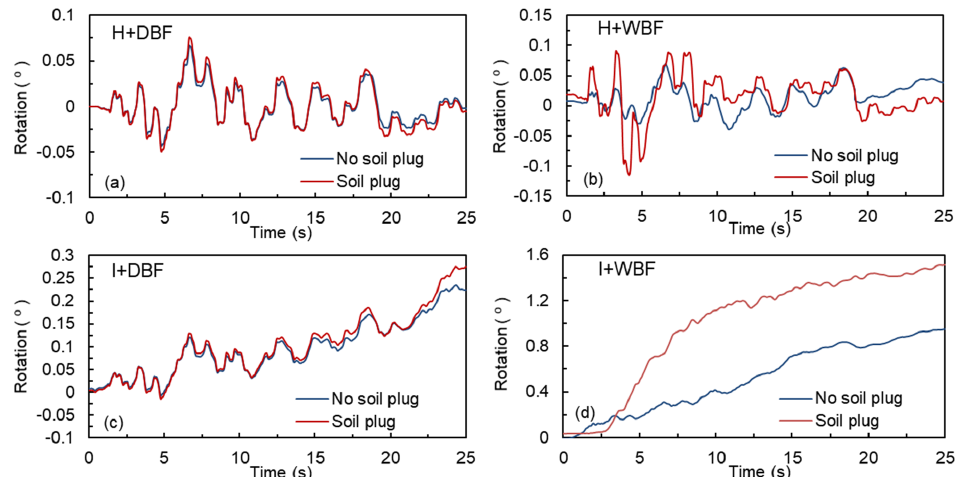
Figure 9. The rotation time histories of bucket foundations in 50% relative density liquefiable seabeds: ( a ) deep bucket foundation (DBF) in horizontal liquefiable seabeds; ( b ) wide bucket foundation (WBF) in horizontal liquefiable seabeds; ( c ) deep bucket foundation (DBF) in inclined liquefiable seabeds; ( d ) wide bucket foundation (WBF) in inclined liquefiable seabeds. H refers to horizontal seabeds and I refers to inclined seabeds.